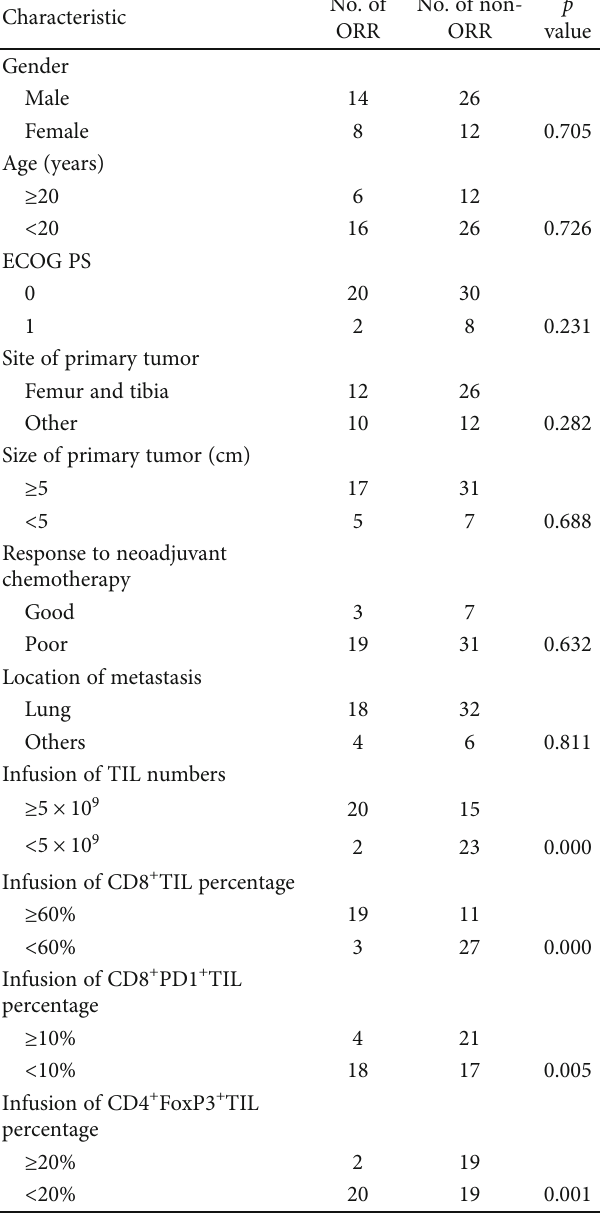
Table 3: Characteristics of patients with ORR ( N = 22 ) and non- ORR ( N = 38